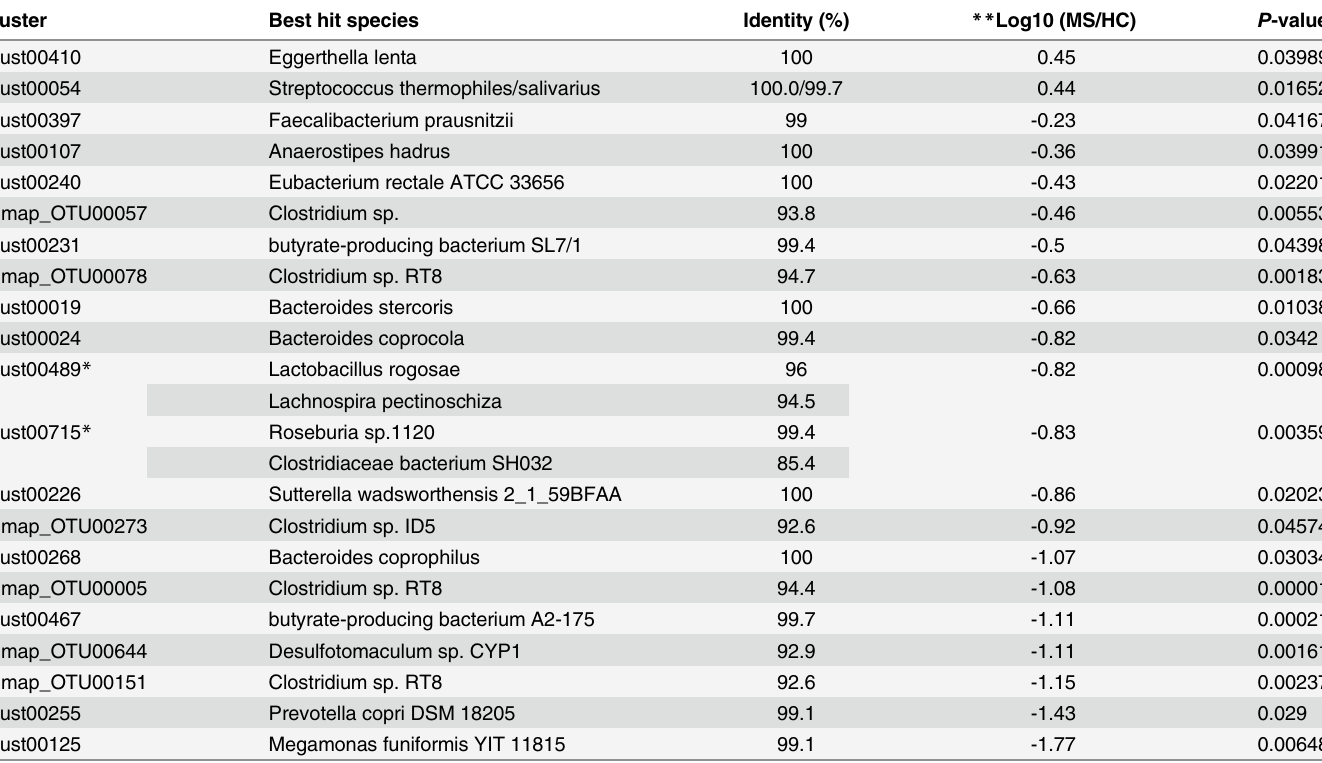
Table 1. The 21 species exhibiting significant increases or decreases in abundance between HC40 and MS20